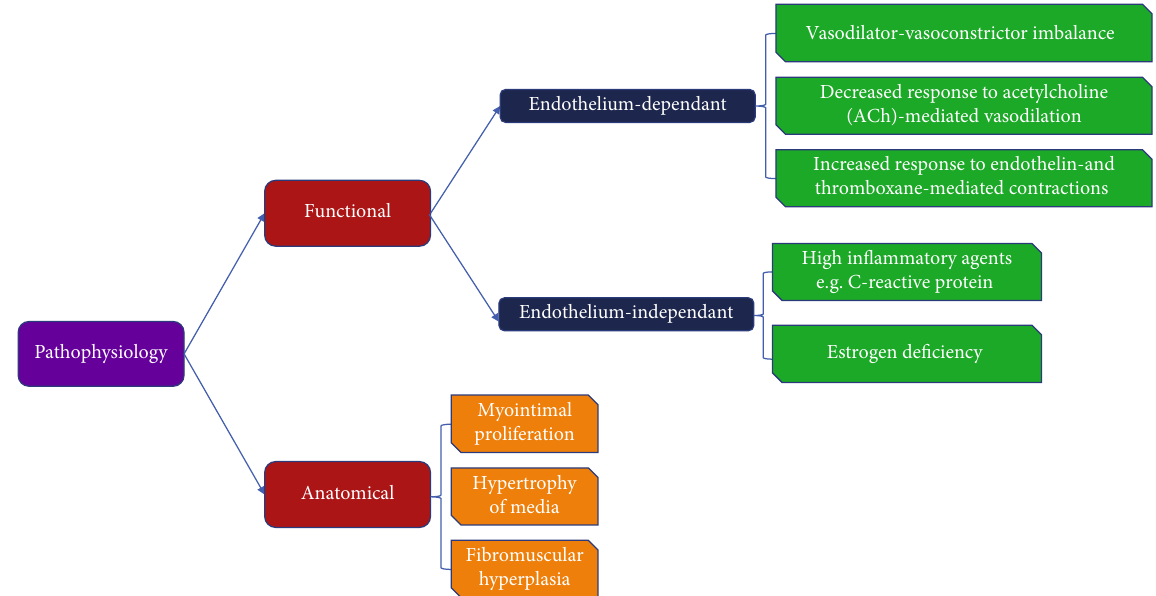
Figure 1: Summary of pathophysiology behind microvascular